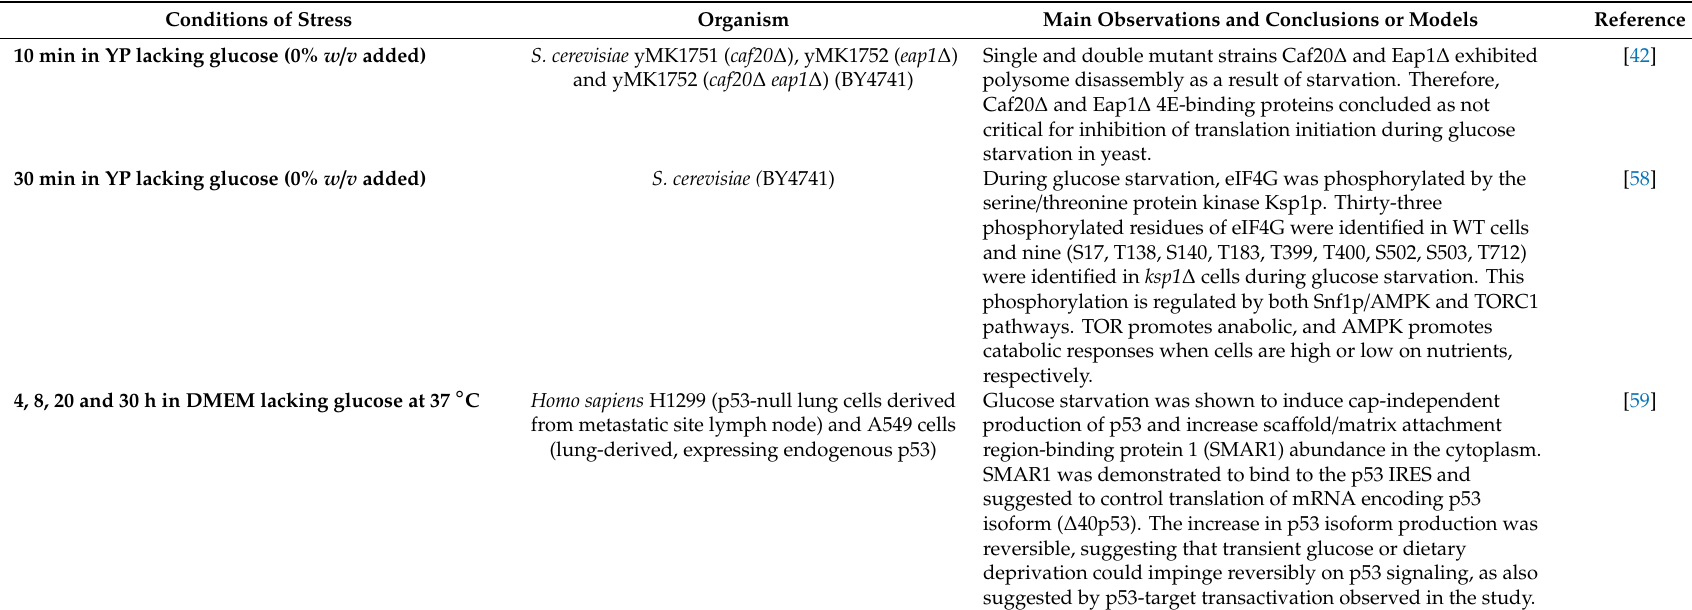
Table 2. Regulation by targeting ribosomal attachment to mRNA during glucose starvation stress.